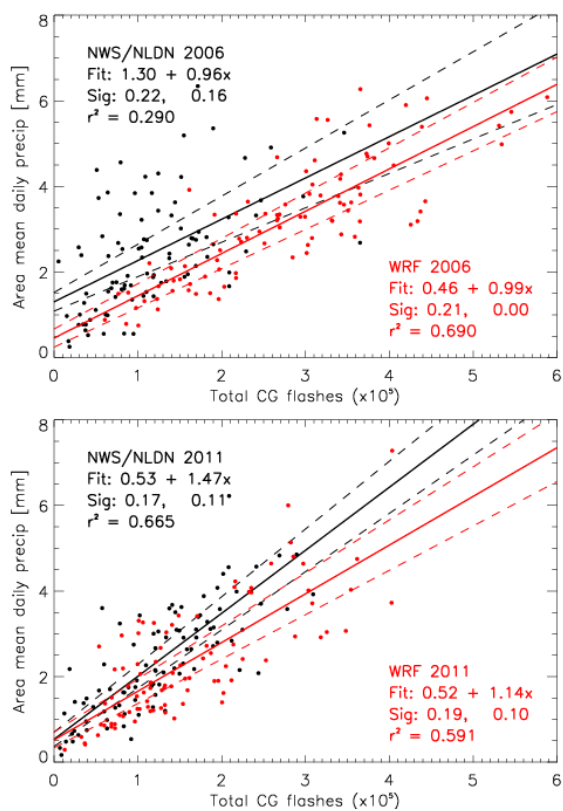
Fig. 6. Total CG flashes (#) versus area-mean daily precipitation ( mm ) within the analysis domain (Fig. 1). Solid line is the least-square linear fit and dashed lines are ± 1 σ for both the constant terms and first-order coefficients. WRF is simualted at 36 km .